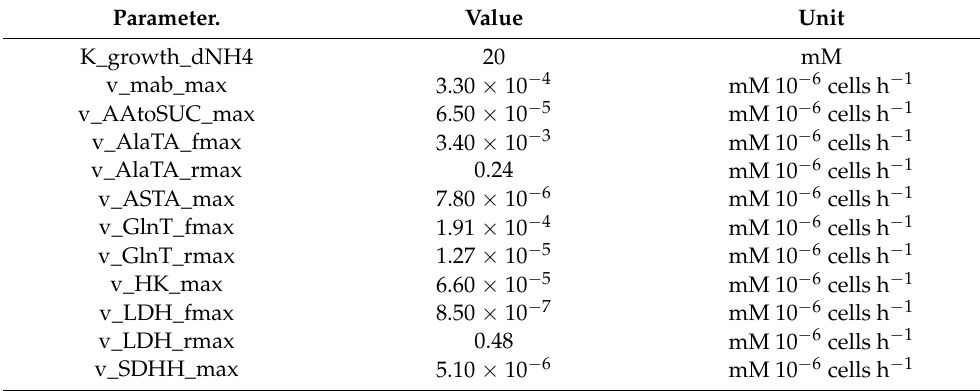
Table 1. Modified parameters and new parameter values.